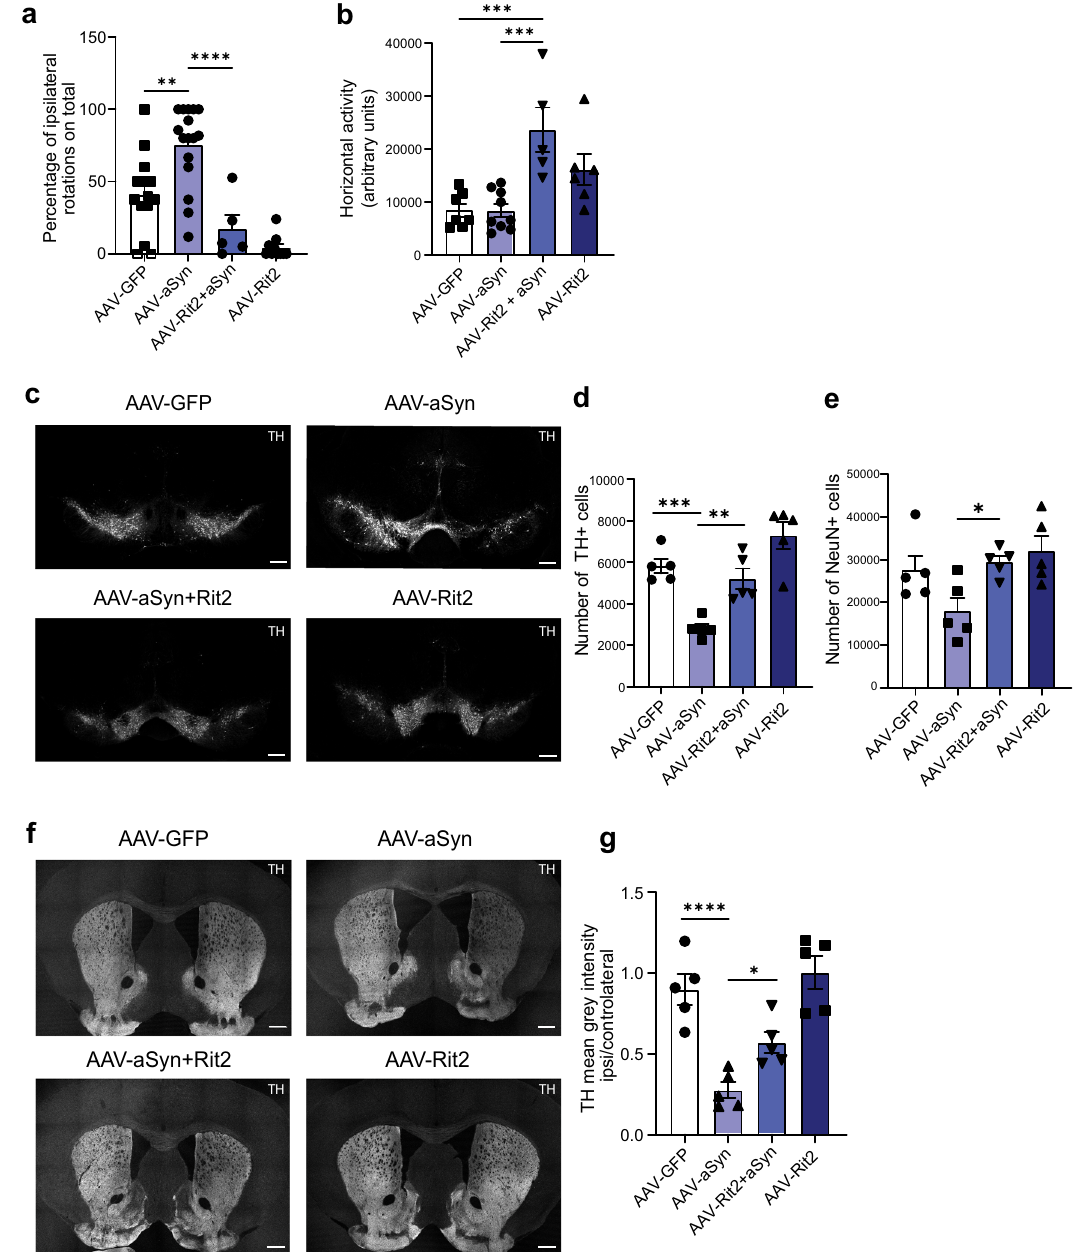
Fig. 5 Enhanced Rit2 expression in the mouse midbrain counteracts aSyn-dependent de fi cits and DA neuron loss. a Overexpression of A53T-aSyn increases the number of ipsilateral rotations and co-injection with AAV-Rit2 or injection of AAV-Rit2 alone increases the number of contralateral rotations. b Overexpression of Rit2 alone or with aSyn signi fi cantly increases horizontal activity in the open fi eld ( n GFP = 7, n aSyn = 9, n aSyn + RIT2 = 8, n RIT2 = 6 for behavioral tests). c IHC for TH was used to count dopaminergic neurons in the midbrain. d Overexpression of A53T-aSyn alone induces a signi fi cant loss of DA neurons, which is attenuated by co-injection of AAV-Rit2. e A53T-aSyn overexpression tends to reduce the number of NeuN + cells in the ipsilateral SNc and concomitant overexpression of Rit2 signi fi cantly preserves NeuN + cells (5 animals/group). f IHC for TH was used to measure the density of DA projections in the striatum. g Overexpression of A53T-aSyn decreases the number of TH + axons in the striatum, which is attenuated by the co-injection of AAV-Rit2 ( n = 5/group for IHC experiments). Data represented as mean ± SEM, * p < 0.05, ** p < 0.01, *** p < 0.001, **** p < 0.0001, one-way ANOVA followed by Bonferroni ’ s post hoc test. Scale bar = 500 phenotypes are similar to what we observed in G2019S-LRRK2 Rit2-KO cells displayed an increased diameter and a drastically cells (bearing a downregulation of Rit2 expression, Fig. 1c) and reduced number of lysosomes (Fig. 8c – e). In addition, when using indicate that the loss of Rit2 affects ALP functionality and is the DQ-Red BSA assay to investigate proteolytic activity of the required for lysosome activity. To con fi rm that these phenotypes lysosomes, the Rit2 KO led to a major decrease in both the are caused by the loss of Rit2 in the cells, we carried out a rescue number and intensity of DQ-Red-BSA spots, indicating Rit2 is experiment, where we overexpressed Rit2 in the Rit2-KO cells. important for lysosomal catabolism (Fig. 8f – h). Of note, these